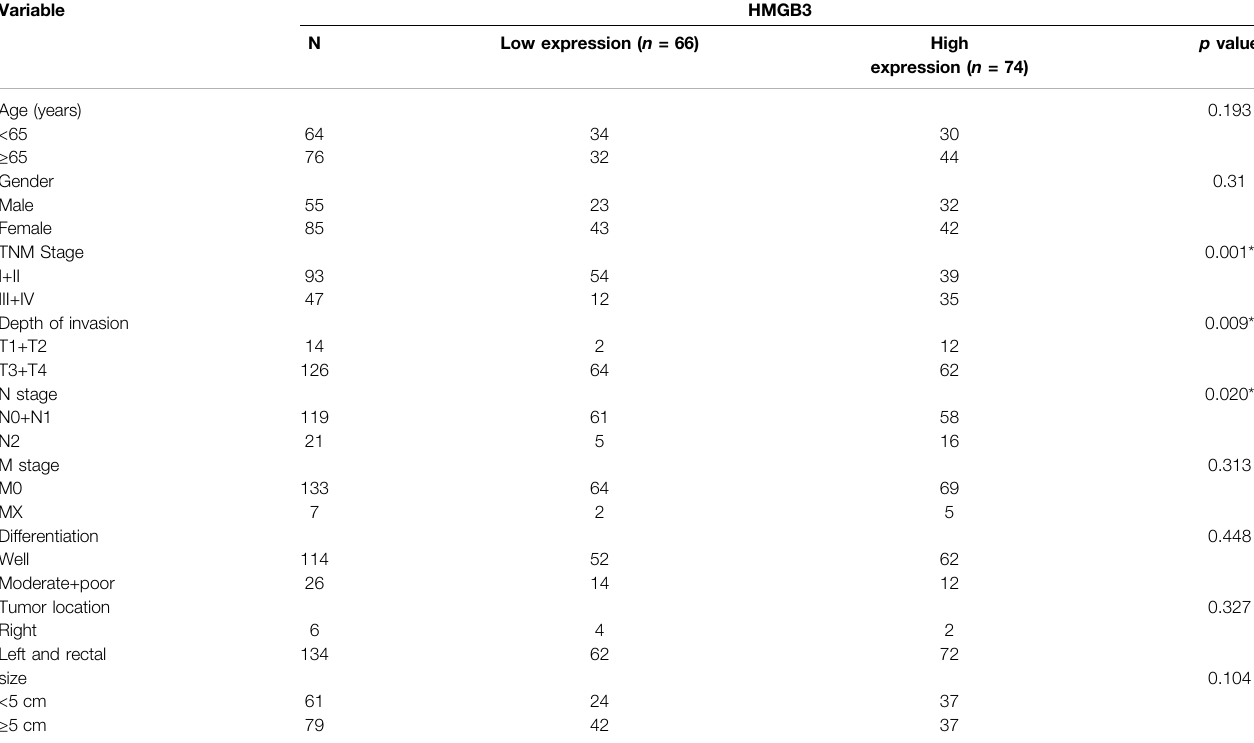
TABLE 1 | Correlation between clinicopathological characteristics of patients and HMGB3 protein expression.